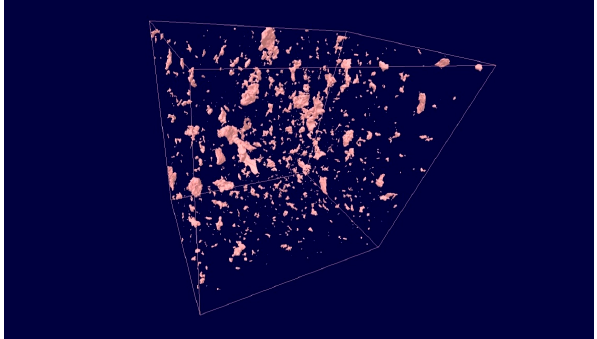
Figure 4. Computer tomography (CT) image of the structure of the adhesive modified with 0.50% of the modifier (lyophilized fungal preparation).